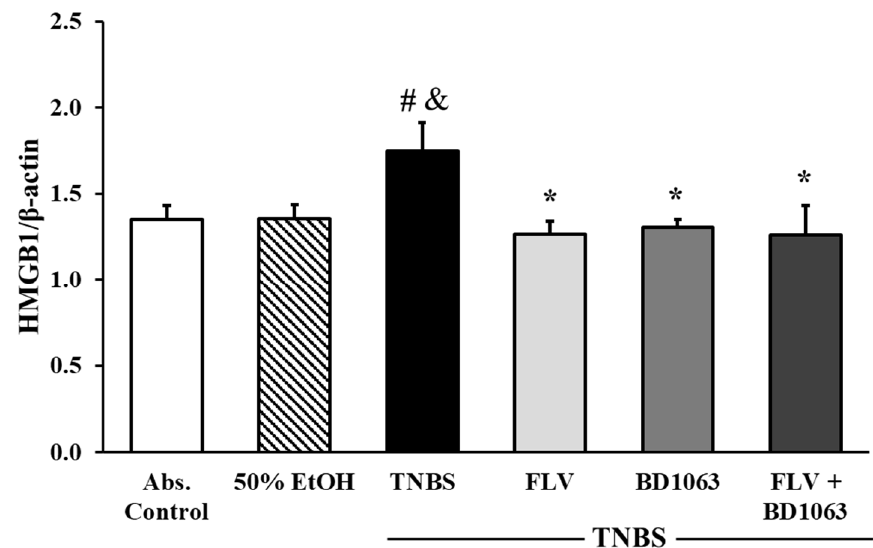
Figure 10. Changes in the expression of high mobility group box 1 (HMGB1), through the administration of sigma-1 receptor ( σ 1R) agonist and antagonist. Abs. control (no treatment), 50% EtOH (50% ethanol enema), TNBS (2,4,6-trinitrobenzenesulfonic acid enema), FLV (TNBS enema + 1 mg / kg fluvoxamine (FLV)), BD1063 (TNBS enema + 0.1 mg / kg BD1063), FLV + BD1063 (TNBS enema + 1 mg / kg FLV + 0.1 mg / kg BD1063). Data are represented as mean ± SEM; ( n = 5–6); statistical significance # p < 0.05 Abs. control vs. TNBS; * p < 0.01 TNBS vs. TNBS + treatment; & p < 0.05 EtOH vs.